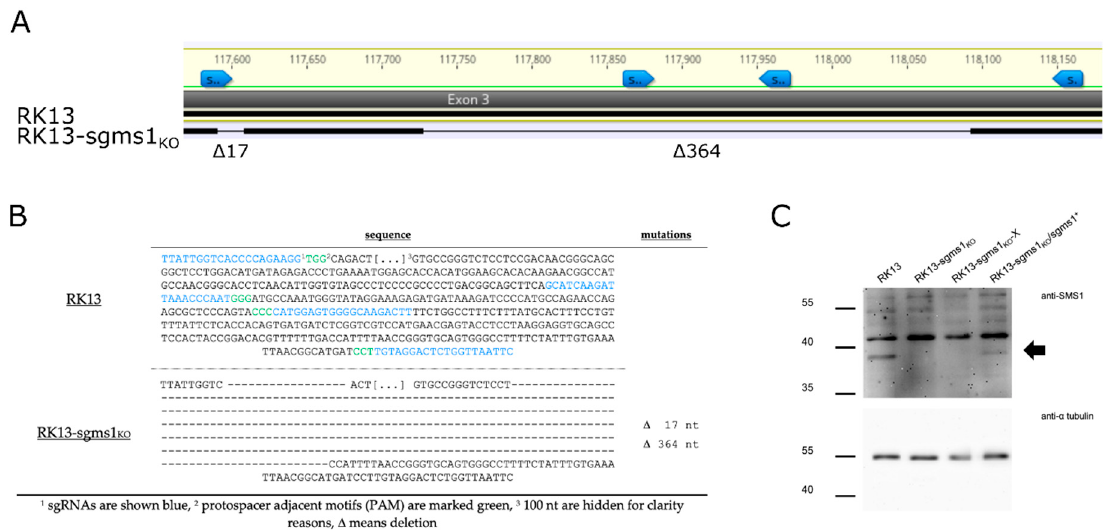
Figure 2. Characterization of RK13-sgms1 KO cells. ( A ) Shown is the targeted sequence of exon 3 of the rabbit sgms1 gene region. The sequence derived from RK13-sgms1 KO (lower line) was compared to the parental rabbit sequence (ENSOCUG00000010965.4, upper line). Due to the large deletion ( ∆ ) identical regions between wildtype and knockout are indicated by black bars and the deleted sequence is represented by a thin line. A detailed analysis on base pair level is shown in ( B ). Locations of sgRNAs are marked in blue ( A , B ), while the corresponding PAM sequence is marked in green. Deletions are shown by hyphen. ( C ) Lysates of wildtype RK13 and RK13-sgms1 KO , as well as RK13-sgms1 KO cells transduced either with an empty vector (RK13-sgms1 KO -X) or with a vector expressing the rabbit SMS1 (RK13-sgms1 KO /sgms1 + ) were probed with a SMS1-specific antiserum. The specific ca. 38 kDa band is marked by an arrow. The α -tubulin monoclonal antibody was used as loading control. Molecular masses of marker proteins (in kDa) are indicated on the